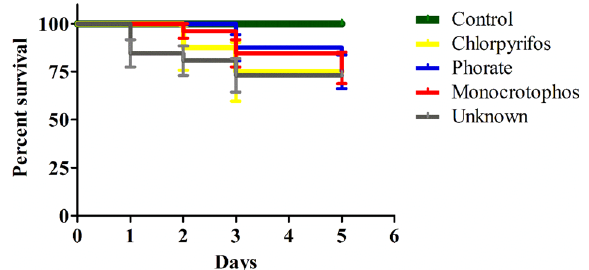
Figure 3. Effect of acute OP poisoning with chlorpyrifos, phorate, monocrotophos, and unknown OP compounds on a human survival plot from Day 1 to Day 5 using the Kaplan ‒ Meier statistics in Prism Software